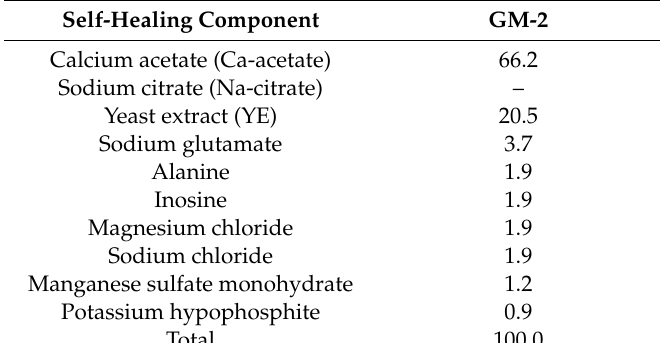
Table 5. Composition of GM-2 (% by mass).